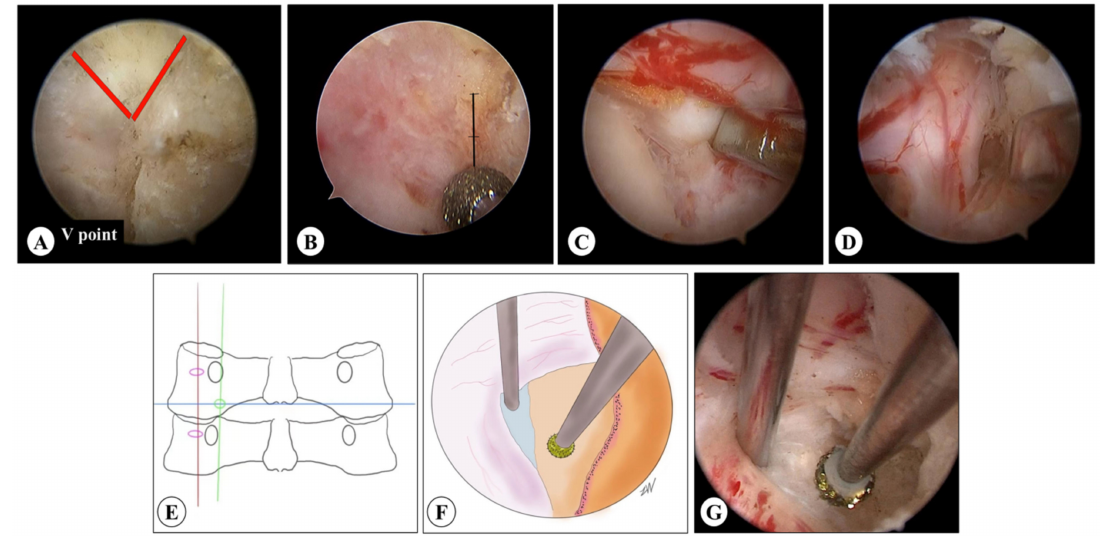
Figure 3. Decompression steps of UBE keyhole surgery. ( A ) The V point. ( B ) The decompression range was estimated based on the diameter of the burr. ( C ) The herniated disc. ( D ) The nerve root after decompression. ( E ) The quarterback K portal (green circle) was located at the intersection of the medial edge of the pedicle (green line) and the horizontal line of the intervertebral disc (blue line). ( F , G ) The nerve root was protected by a Kirschner